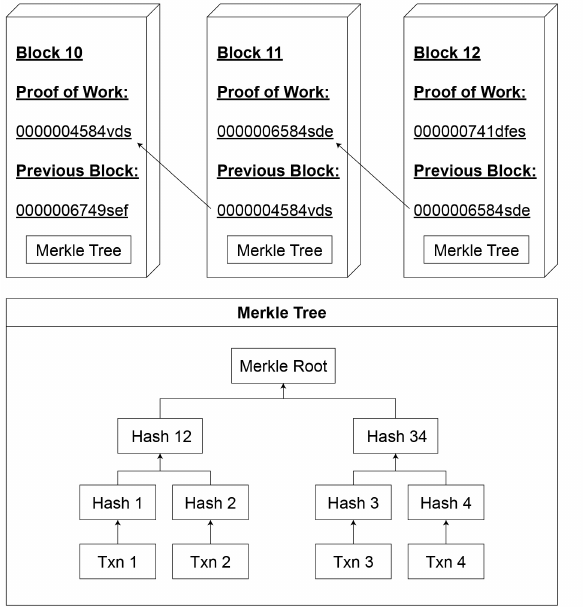
Figure 3. Blocks forming blockchain using hash